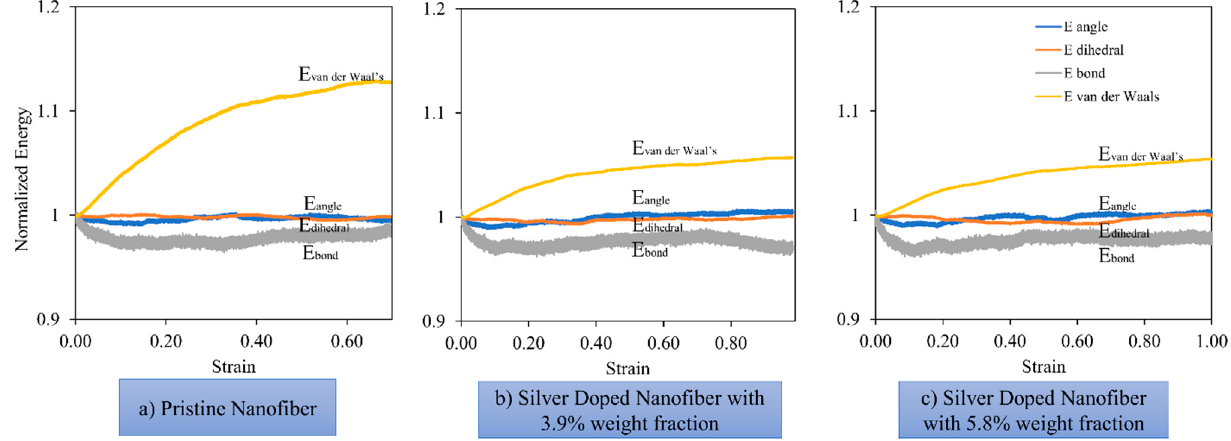
Figure 13. Energy decomposition for pristine ( a ) and doped nanofibres with 3.9% ( b ) and 5.8% ( c ) weight fractions of Ag